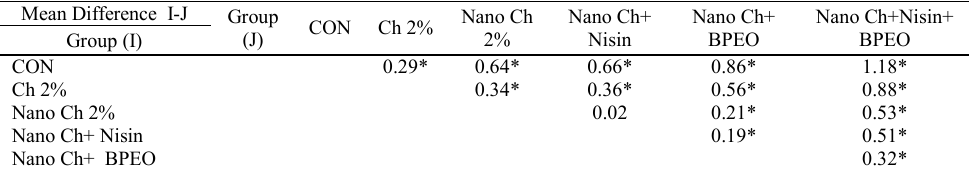
H counts (Log CFU/g) among treatments when compared with each other 157 7 during the study